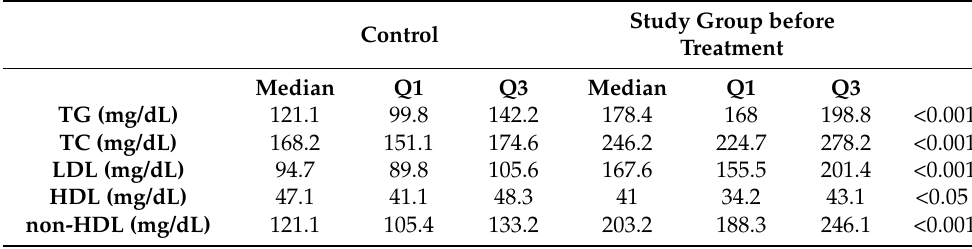
Table 2. Concentrations of plasma lipids in study group before treatment versus control